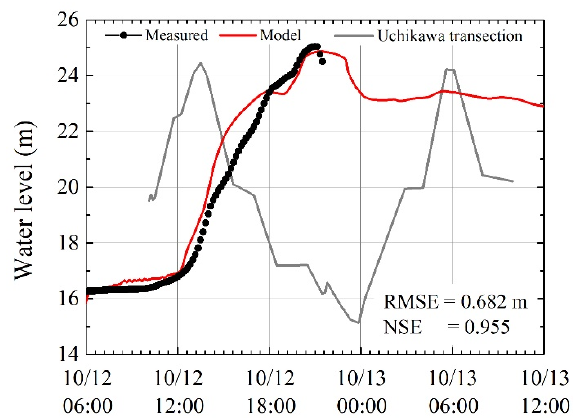
Figure 7. Time-series comparison result of the modeled and measured water level data at Uchikawa Station.